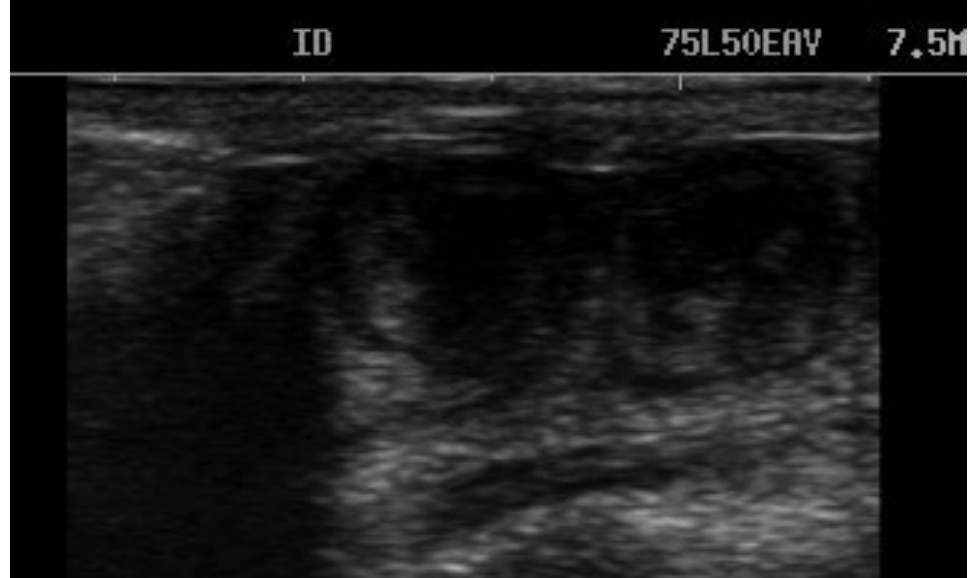
Figure 1. Ultrasound cross-sectional image of uterine horns at bifurcation.